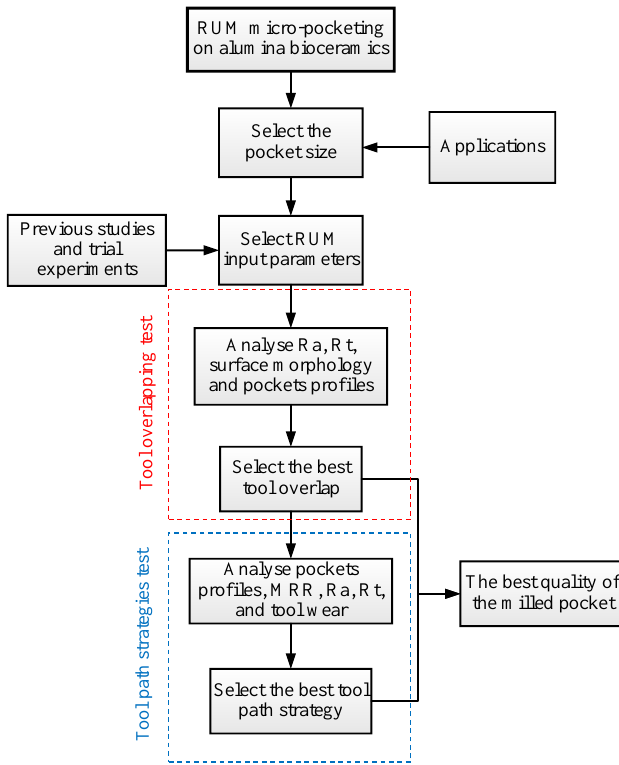
Figure 6. Research methodology.